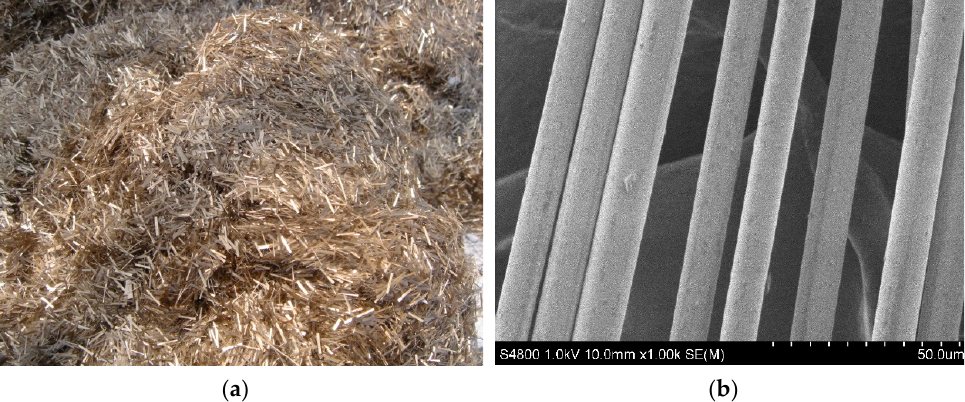
Figure 1. Optical and scanning electron microscopy picture of basalt fiber: ( a ) appearance and Figure 1. Opticalandscanningelectronmicroscopypictureofbasaltfiber: ( a )appearanceand( b ( b ) 1000 times. Table 1. SBS ‐ modified asphalt test results and technical indicators.